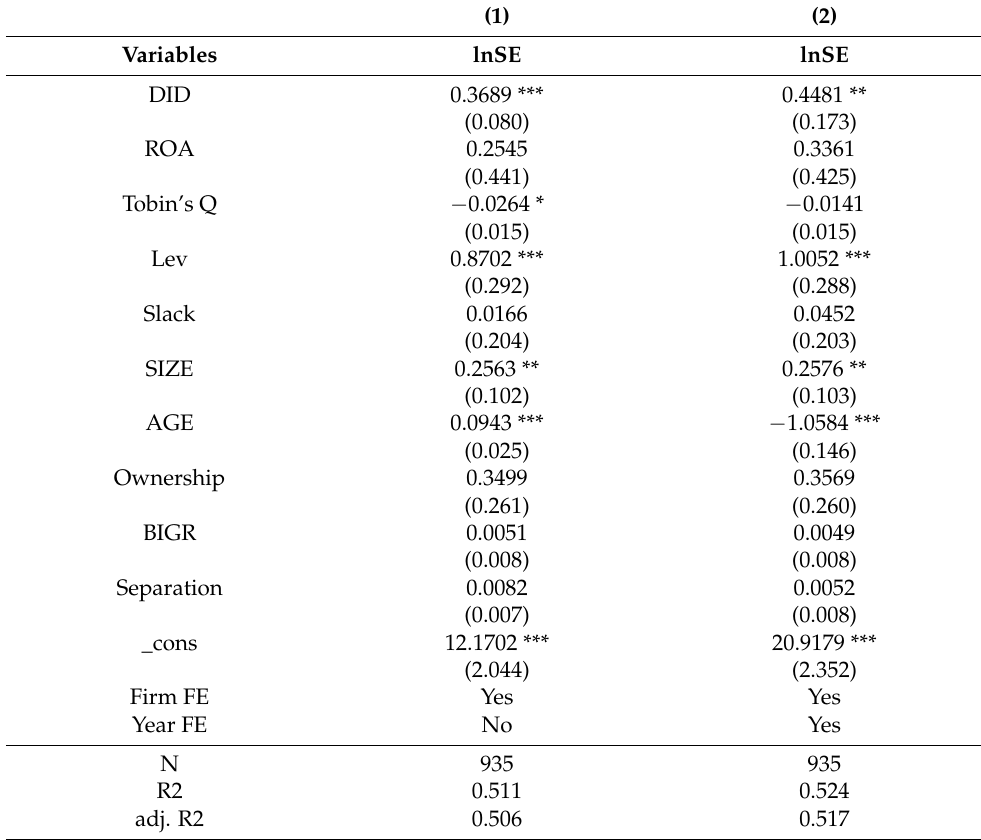
Table 10. Robust Test: Confounding